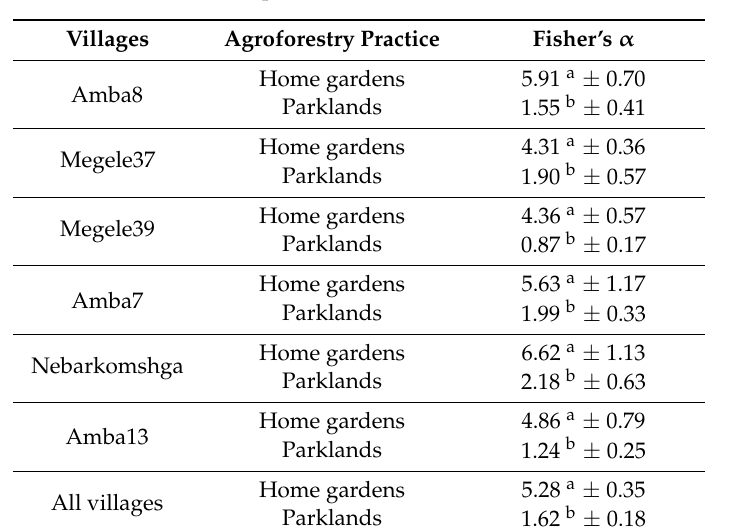
Table 6. Comparison of Fisher’s α diversity index between home gardens and parkland agroforestry systems in Assosa district, western Ethiopia. Values are means ± standard errors.